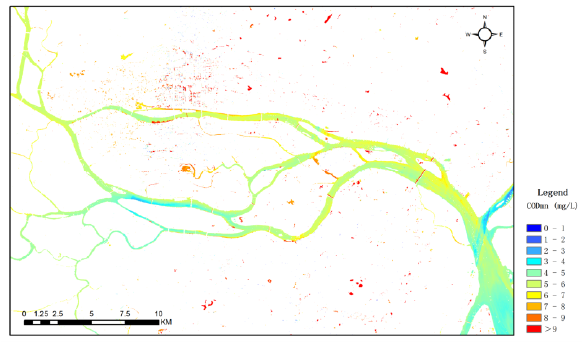
Figure 8. The inversion result of COD Mn in GPR based on GF-1 PMS